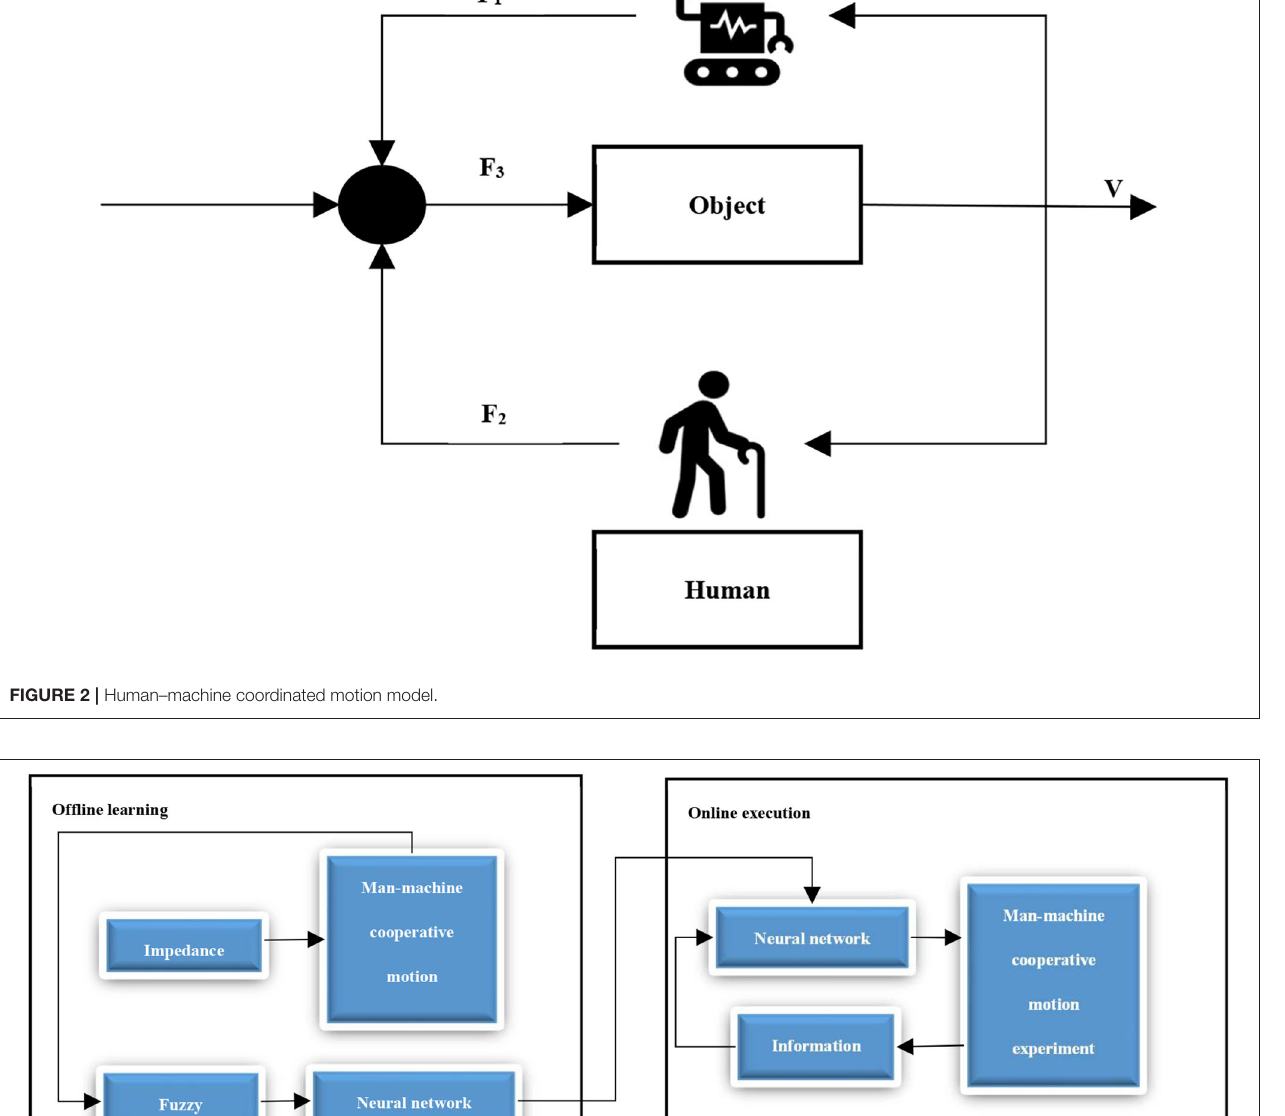
the human–machine coordinated motion experiment